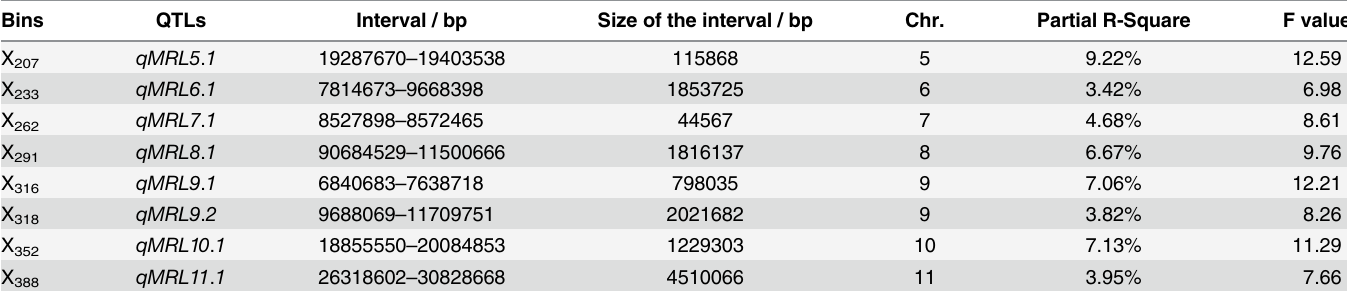
Table 6. QTLs mapping of MRL.